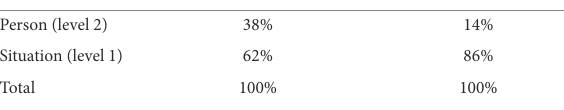
TABLE 3 Proportions of variance at the between-person (level 2) and within-person (level 1) levels for state meaningfulness and state